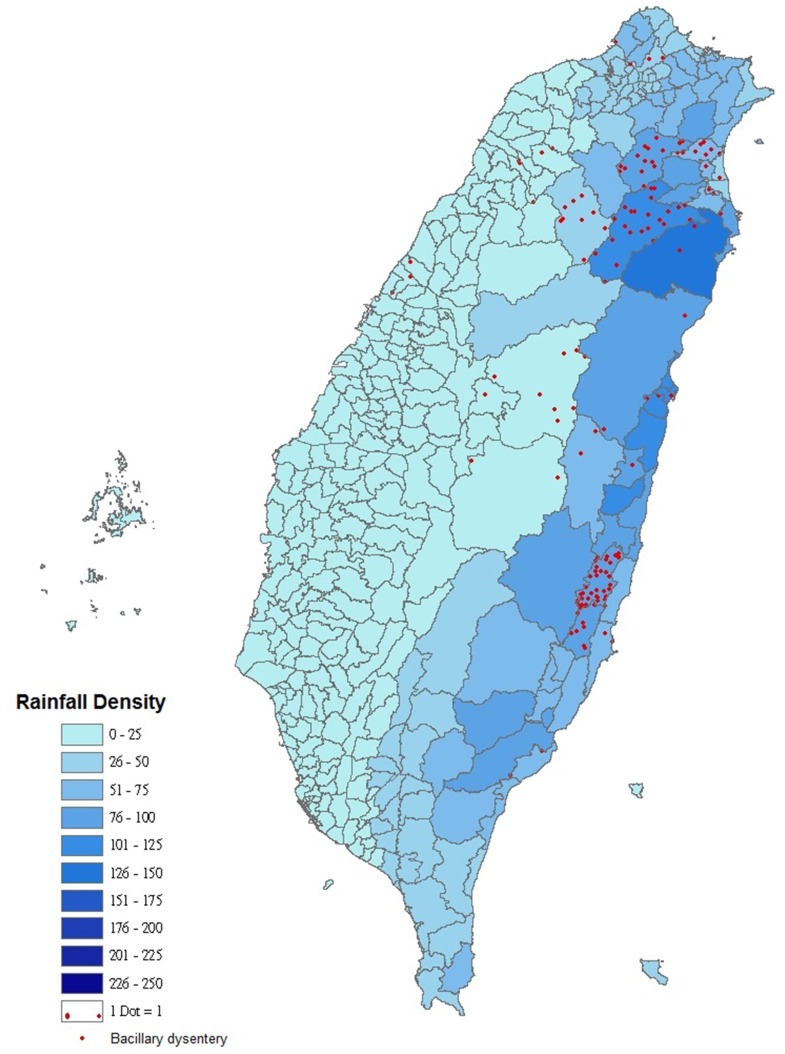
Distribution of daily mean precipitation (in mm after Typhoon Nari) and the individual cases of bacillary dysentery with a 7-day lag after Typhoon Nari, 2001.